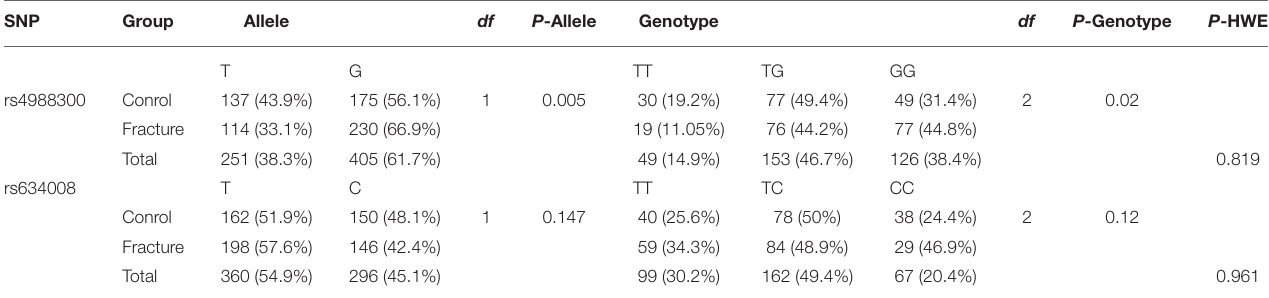
TABLE 3 | Distributions of allele and genotype frequencies in the study sample.